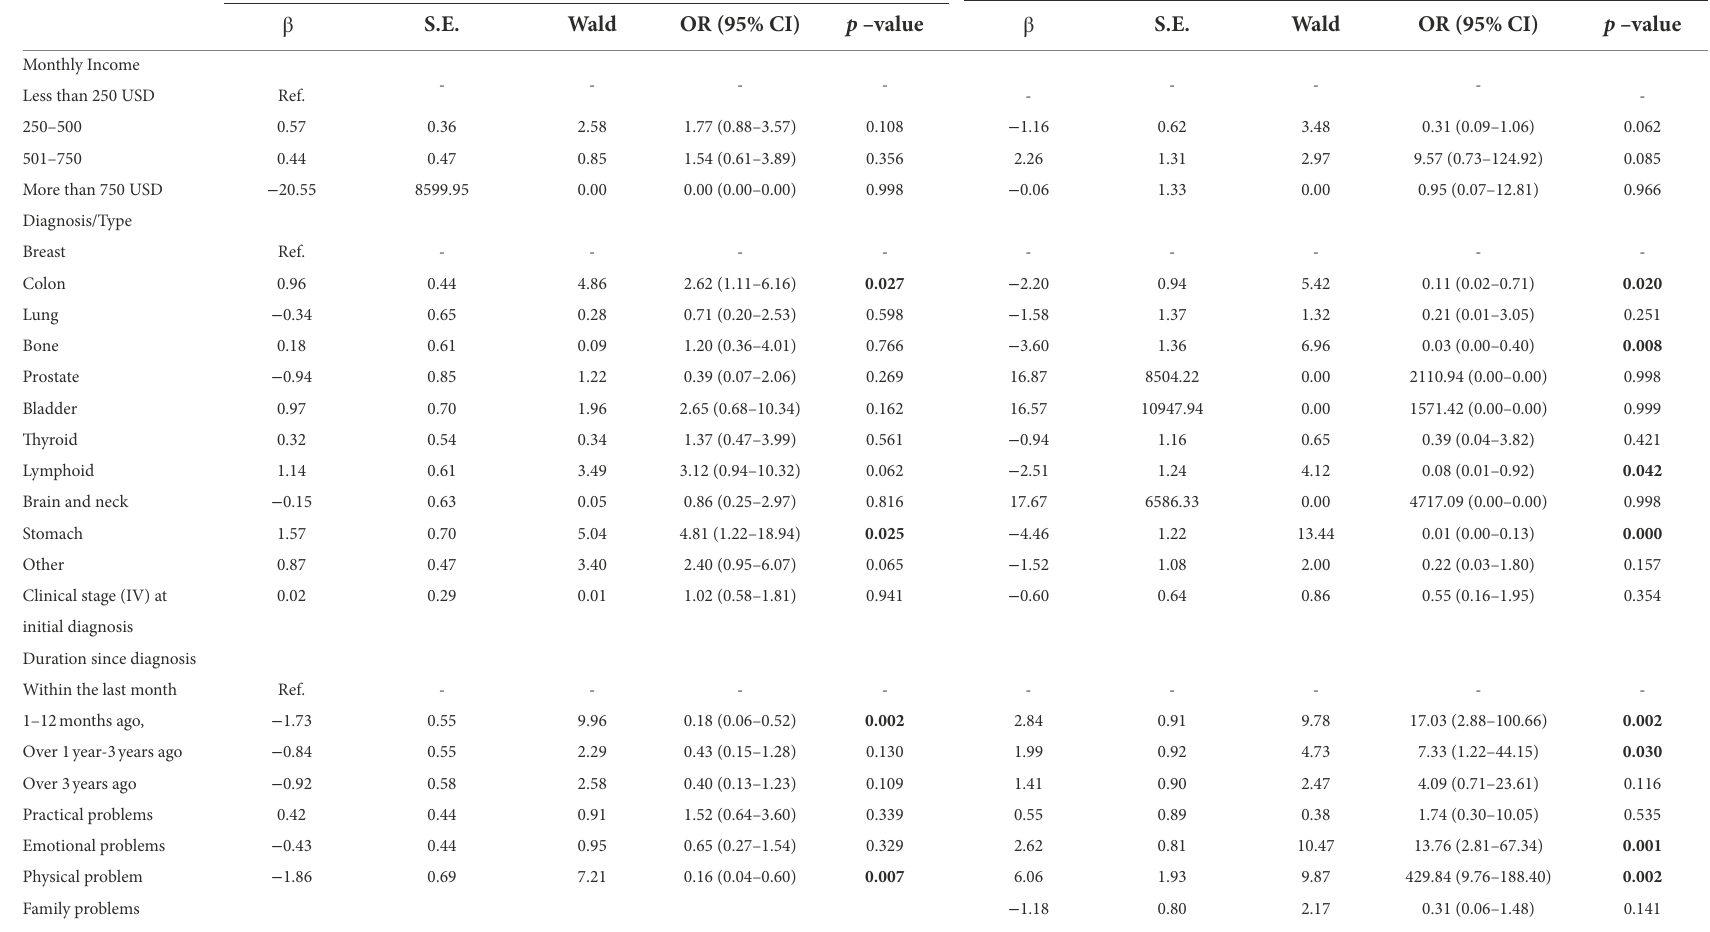
TABLE 3 Multivariate logistic regression model for both scales.